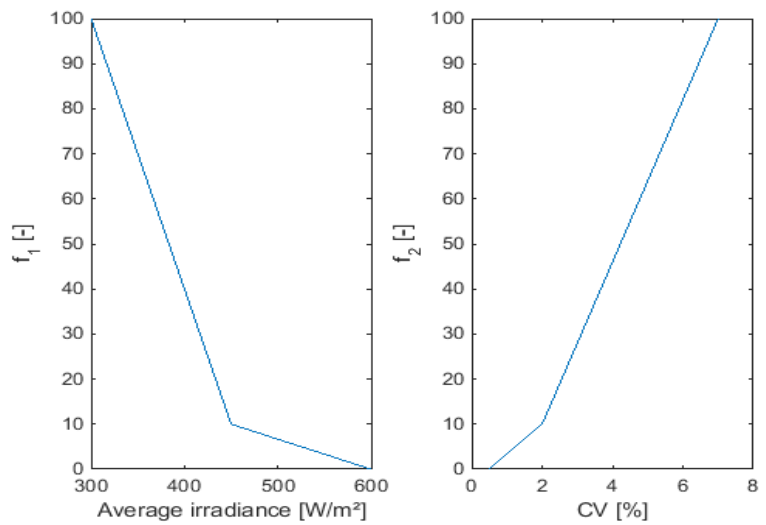
Figure 3. Objective functions used for the multiple objective genetic algorithm. ( Left ): average irradiance; ( Right ): Coefficient of Variation